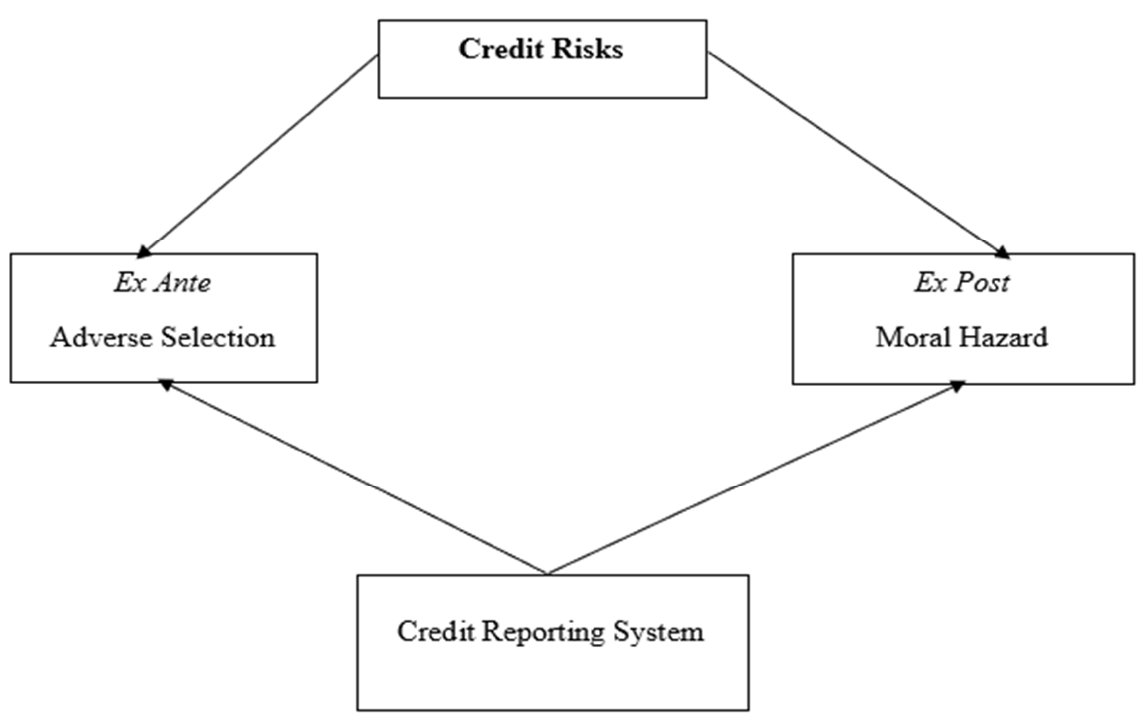
Figure 1. Information Asymmetry and Credit Risks. Source: Adapted from (Tfaily